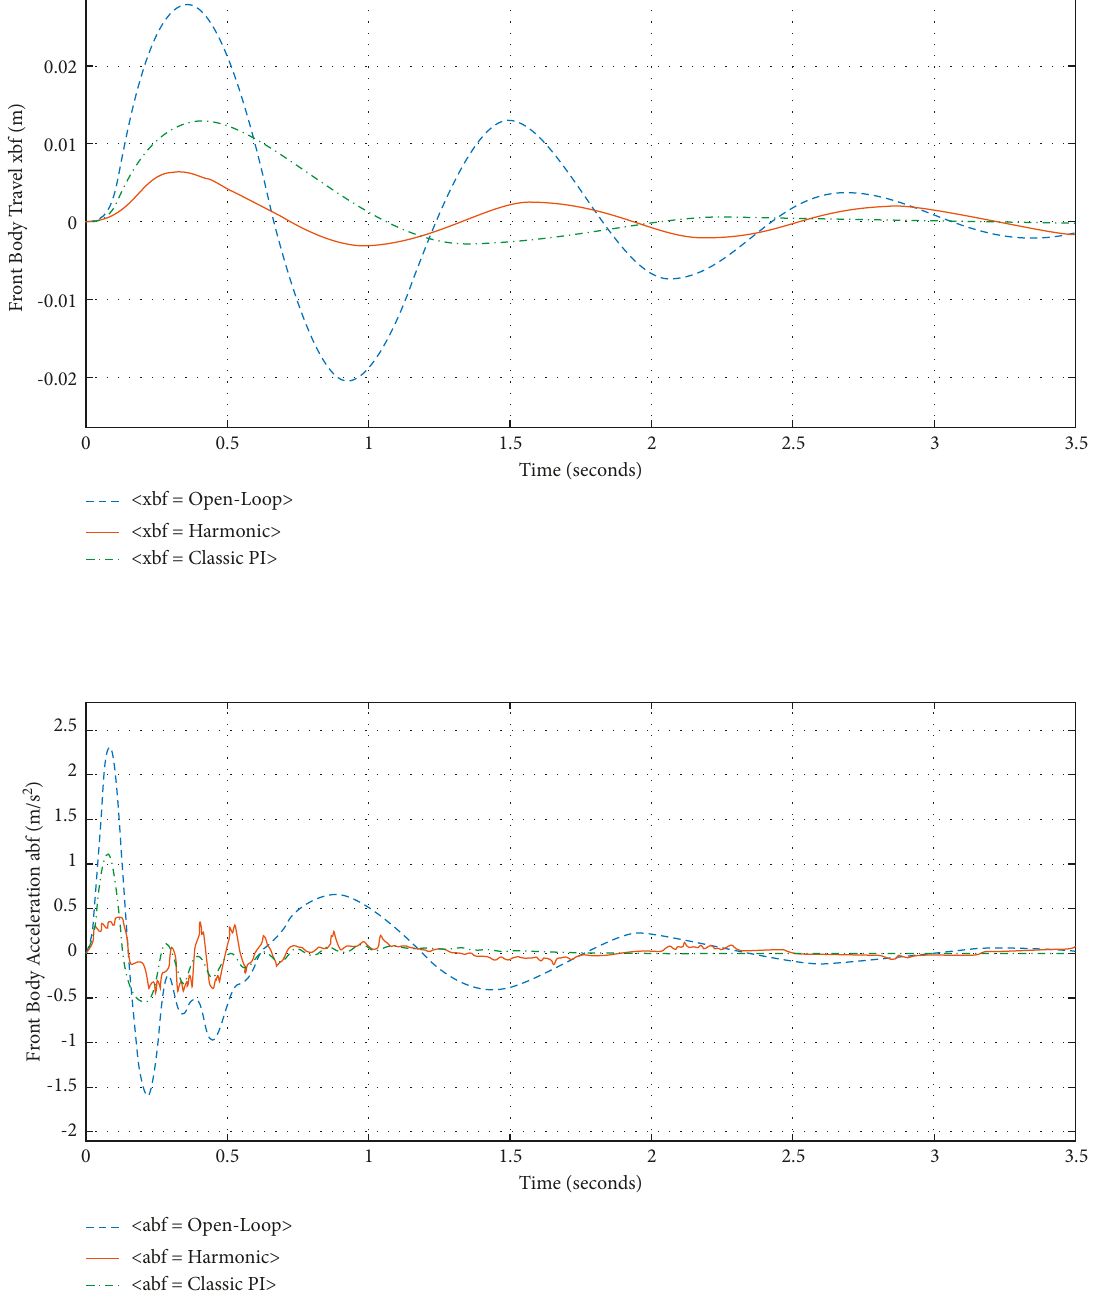
Figure 5: Front body travel x a bf and front body acceleration bf results: blue dash line means open-loop, red continuous line means harmonic, and green dash line means classic